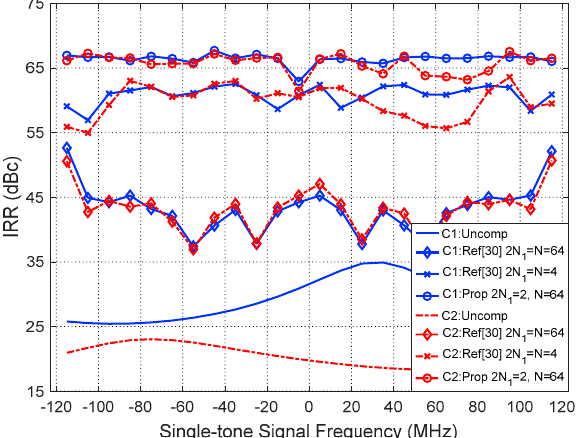
Figure 10. Spectral IRR performance of the I / Q mismatch Cases (C1 / C2) in the baseband before and after compensation.